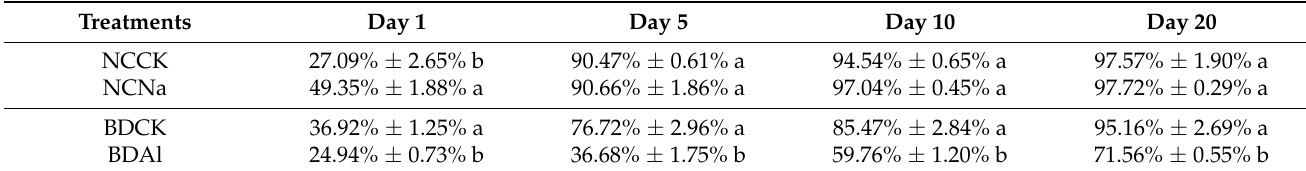
Table 1. The Fe(III) reducing ratio during anaerobic incubation of paddy soils with acidification or alkalization.